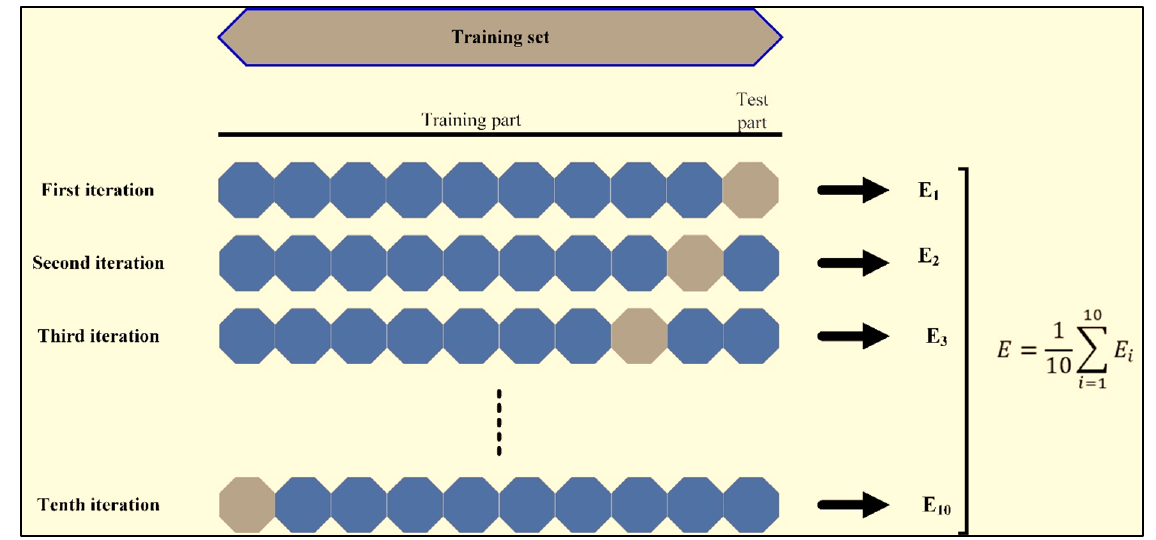
Figure 5. Tenfold cross-validation process.